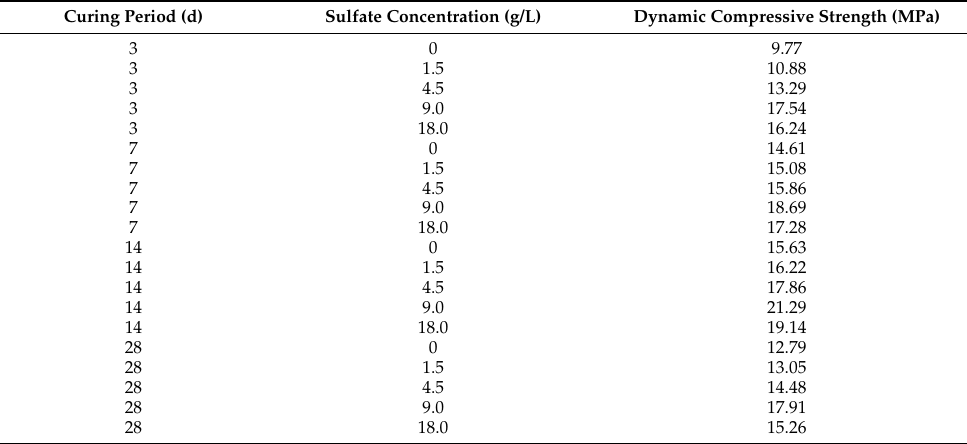
Table 5. Dynamic compressive strength of cement soil specimens.